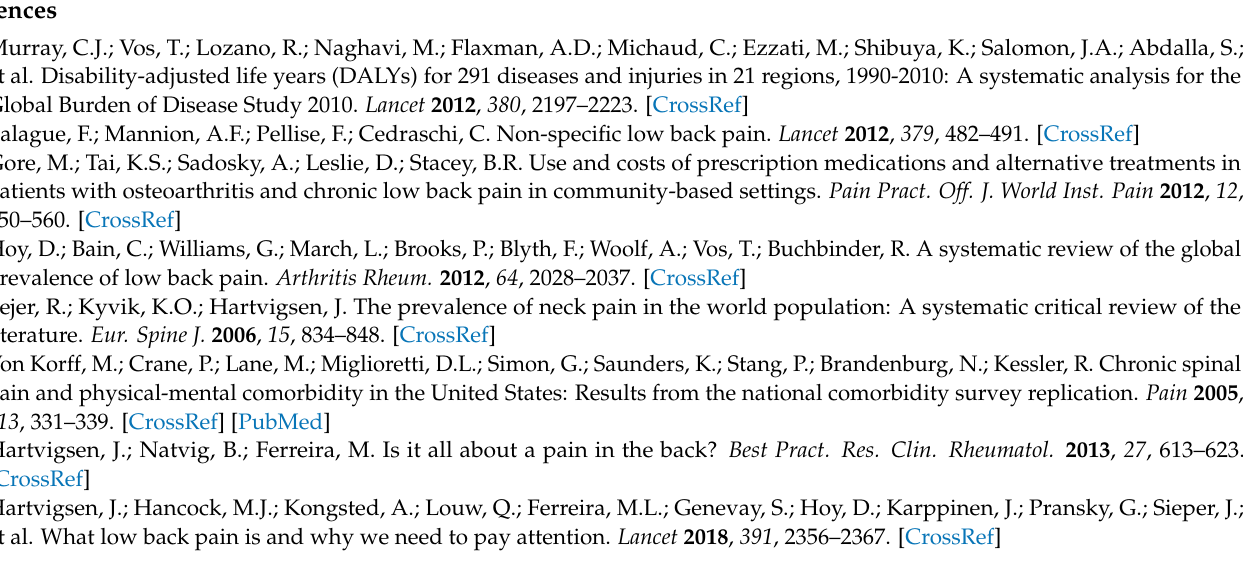
Table S2: Overview excluded articles screened on full text, Table S3: Quality of Evidence - Modified version of the Grading of Recommendations Assessment, Development, and Evaluation